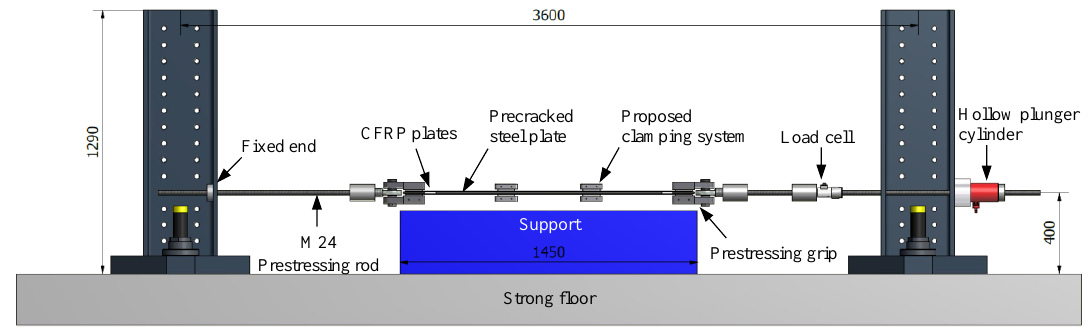
Figure 6. Prestressing setup (all dimensions are in mm).